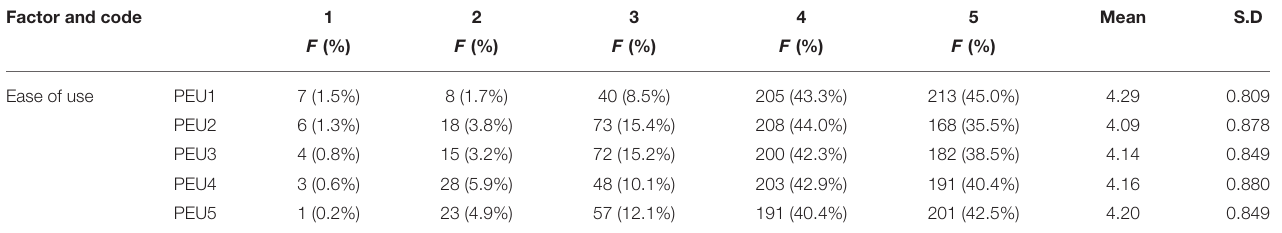
TABLE 9 | Measuring perceived ease of use (PEU).